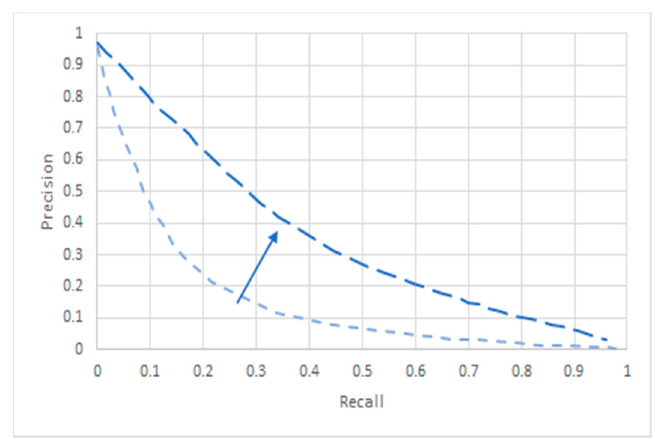
Figure 4. Simultaneous optimization of the precision and recall.